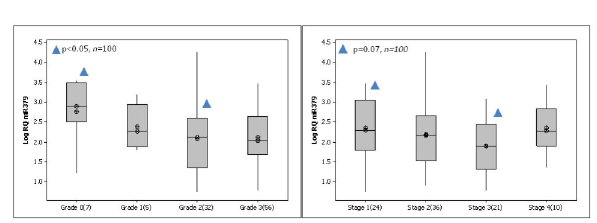
Figure 2. miR-379 expression across tumour stage and grade. (A) miR-379 expression across tumour stage. With increasing tumour stage, the level of miR-379 decreased significantly (p<0.05) (B) Level of miR-379 across tumour grade. A similar trend was observed for tumour grade, however it did not reach significance (p=0.128). doi: